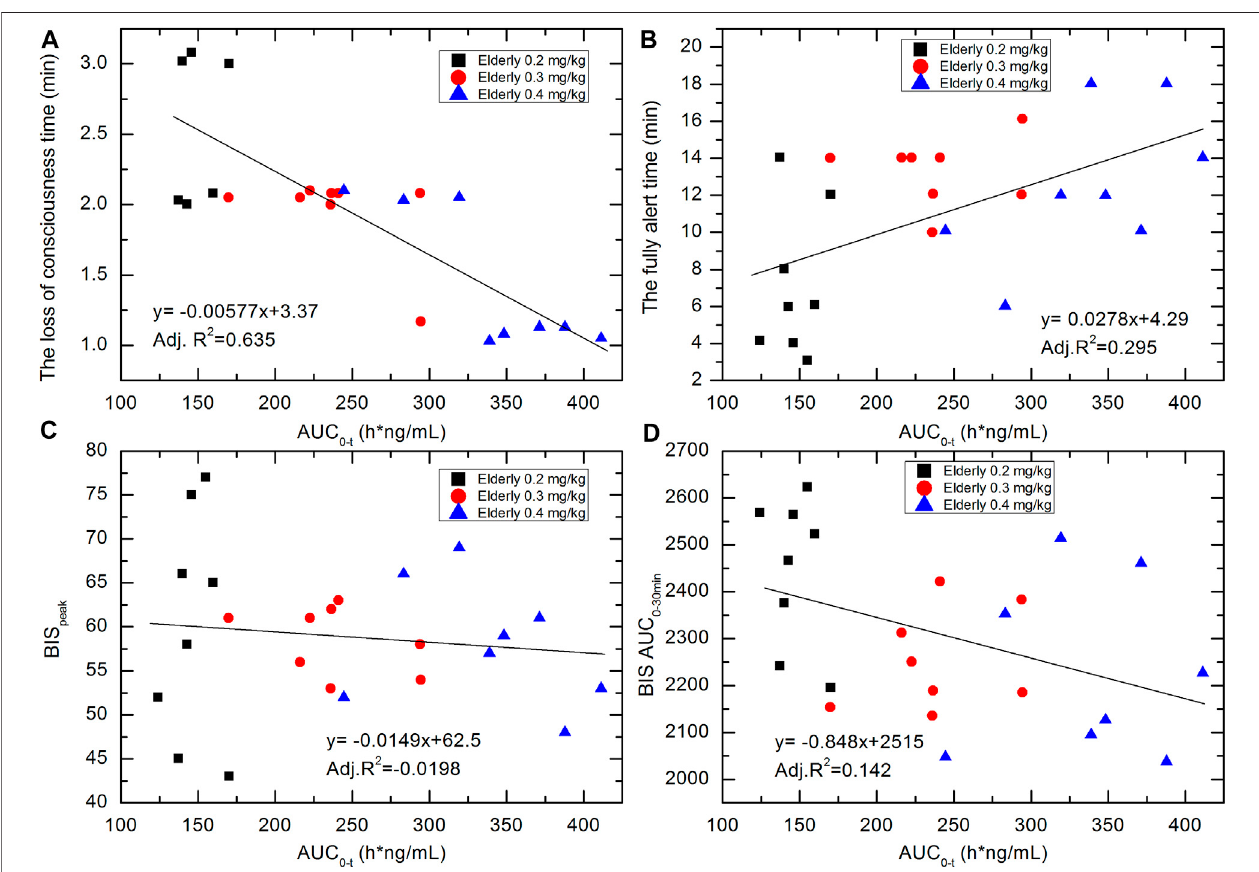
FIGURE 6 | Correlation scatterplots of HSK3486 exposure level (AUC 0-t ) with (A) loss-of-consciousness time; (B) fully alert time; (C) BIS peak ; and (D) BIS AUC 0 – 30 min for elderly 0.2, elderly 0.3, and elderly 0.4 mg/kg